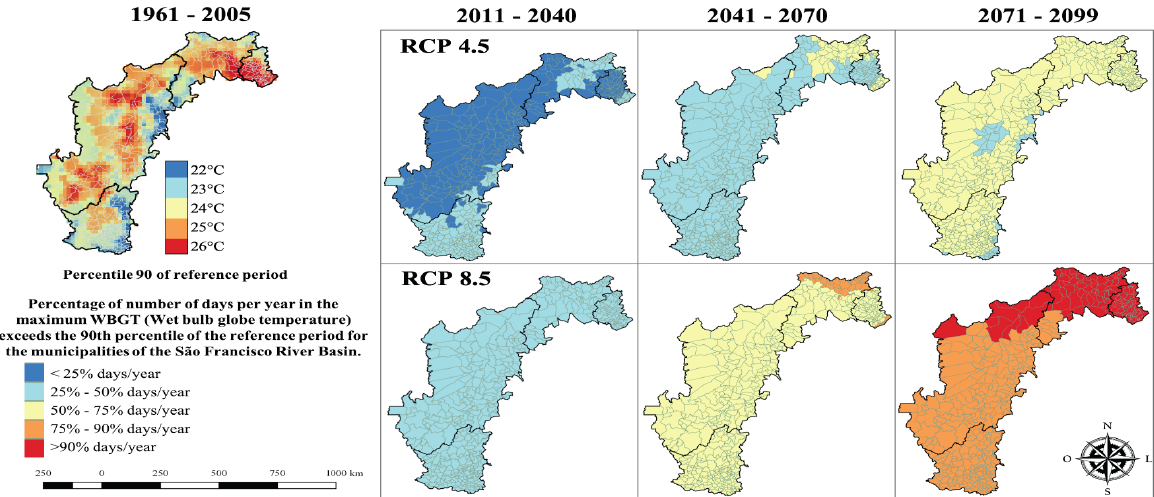
Figure 4 - Projections of the average number of days in which the maximum WBGt exceeded the 90th percentile of the reference period (1961-2005) for the climate scenarios RCP 4.5 and 8.5 and time windows 2011-2040, 2041-2071 and